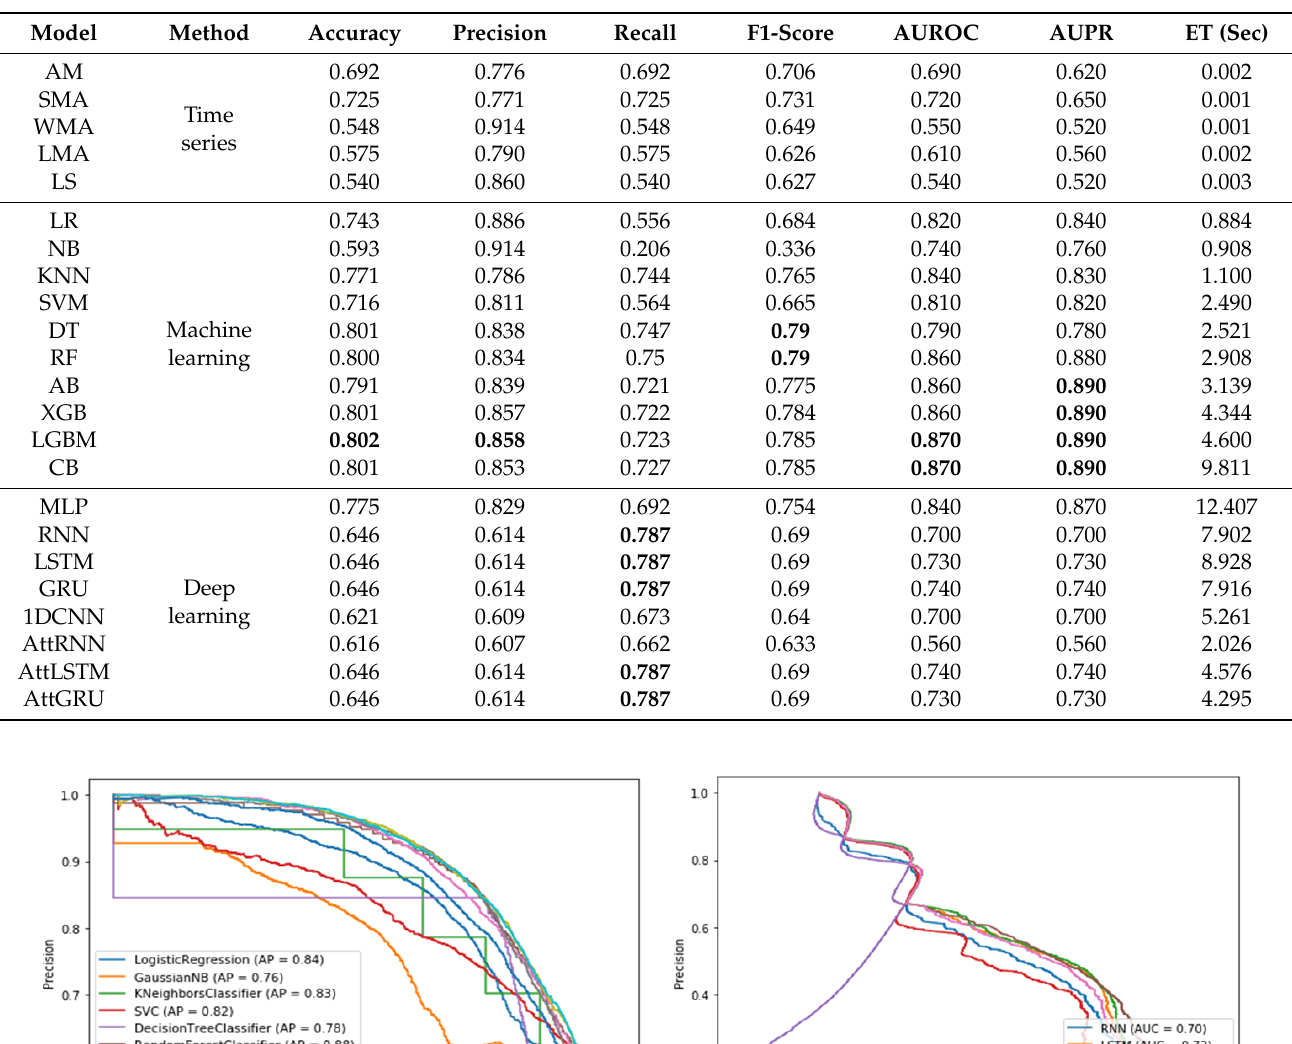
Table 2. Performance values of base models.